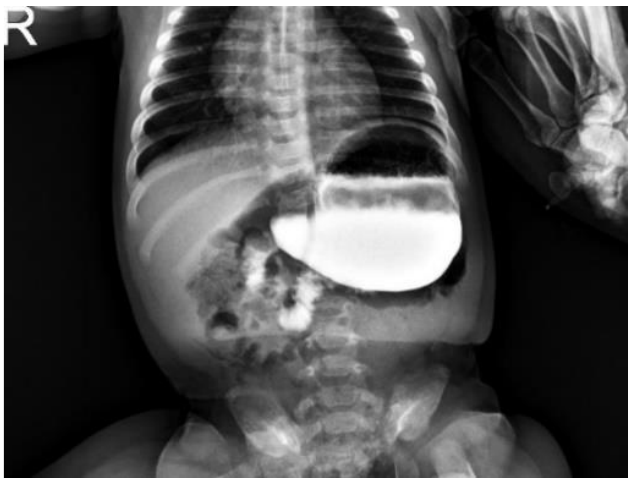
Figure 1. Upper GI contrast study: 4 months old infants presenting with vomiting and failure to thrive. The contrast report showed an enlarged stomach, the gastric bubble projecting above the cardias, a more elevated left hemidiaphragm and the gastric antrum higher than the pylorus as for organo-axial volvulus. Table 1. Patient demographics and presenting symptoms.